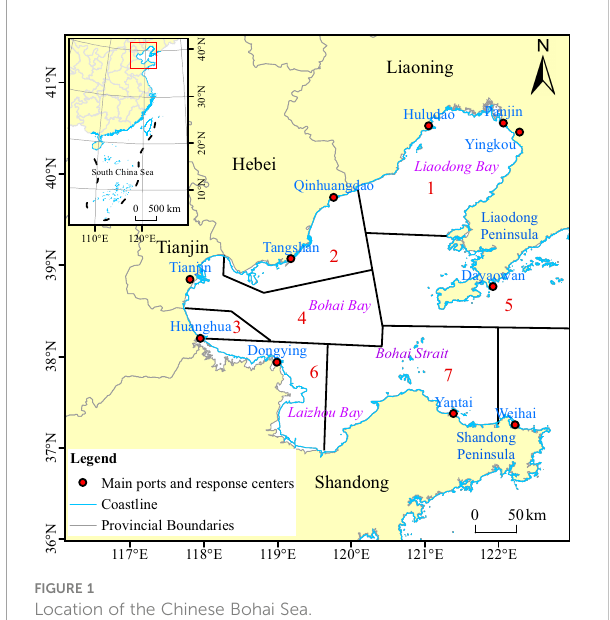
FIGURE 1 Location of the Chinese Bohai